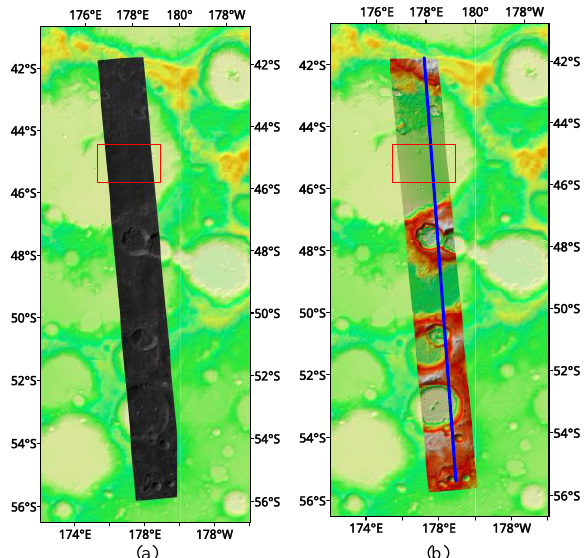
Figure 4. The forward view of the stereo pair (a) and the generated DEM (b) from orbit 0392 overlaid on the SLDEM (Barker et al., 2016). The blue line indicates the profile in Figure 5. The white gap is the artifacts caused by the rendering software ESRI ArcMap around the antimeridian of the